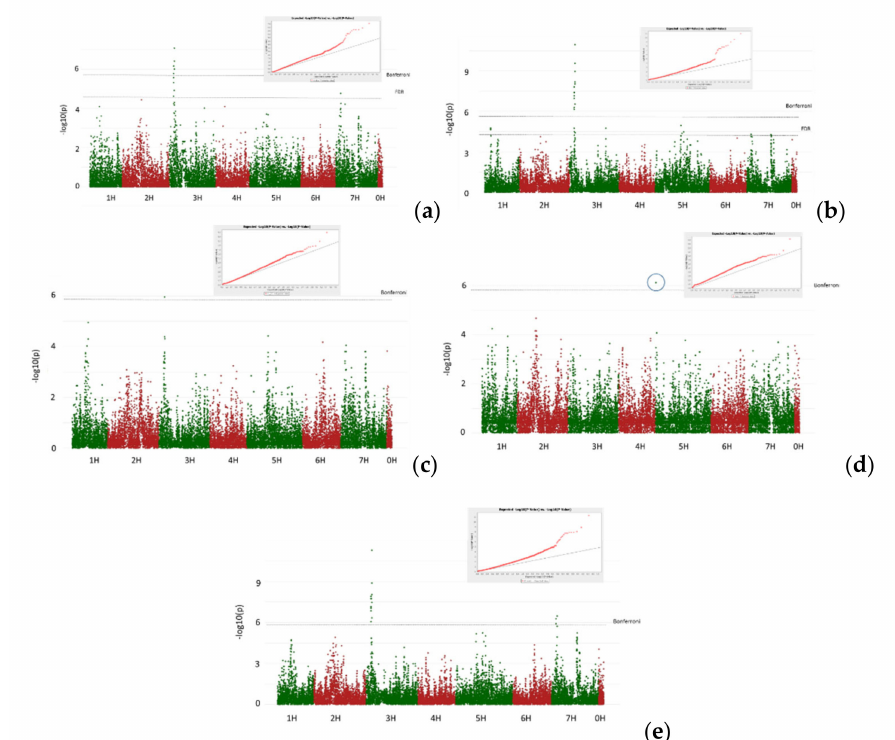
Figure A3. Manhatten plot for GLM + PCA model with QQ plot ( a ) O18.2 seedling, ( b ) Ch3 seedling,